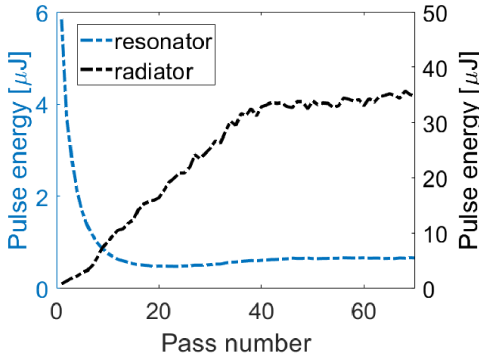
FIG. 6. Overview of the photon pulse energy per pass in the resonator (at the end of the modulator, left scale) and in the radiator (at the end of the radiator, right scale). The output wavelength of the simulation is 2.5 nm, which is the 20th harmonic of the 50 nm